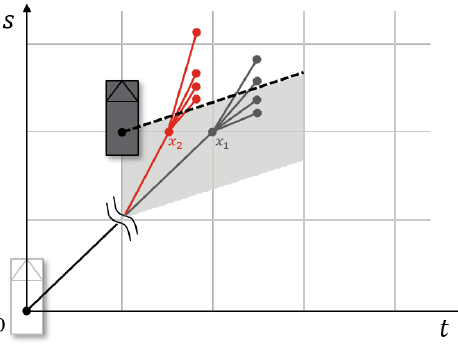
Figure 8. Analytic calculation of the Inevitable Collision State.